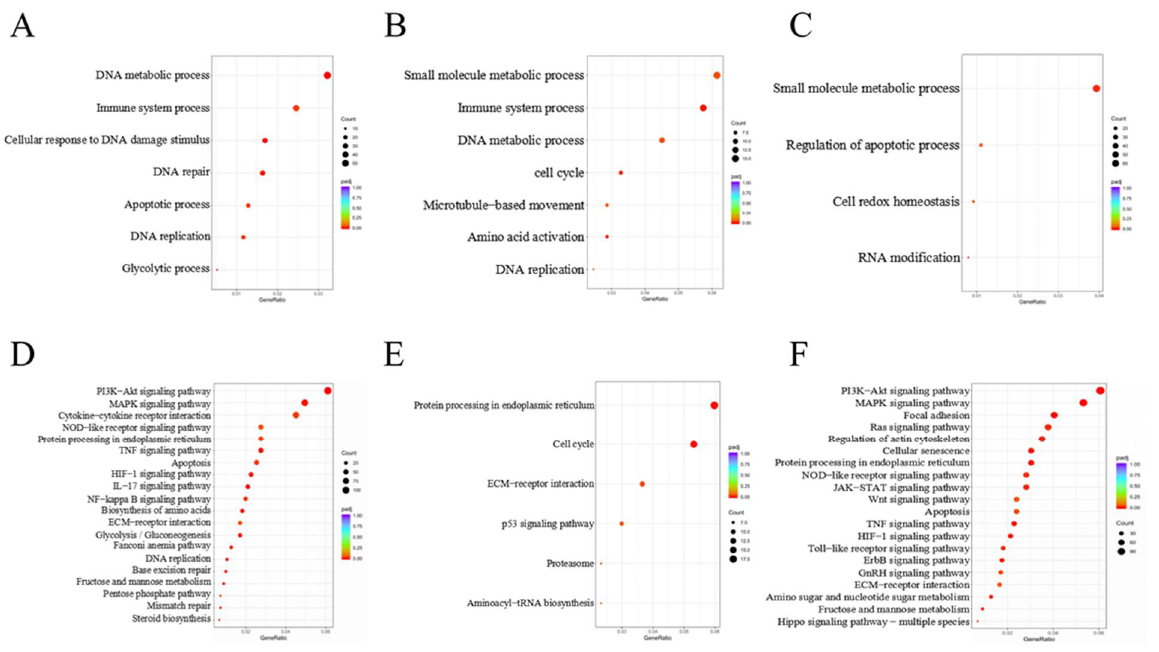
Figure 4. GO and KEGG biological processes involving DEGs in Equus asinus SCs exposed to DON and ZEA. ( A ) GO enrichment of 5763 DEGs in the 10 µ M and 30 µ M DON-exposed Equus asinus SCs, including biological process, cellular component, and molecular function. ( B ) GO enrichment of 685 DEGs in the 10 µ M and 30 µ M ZEA-treated Equus asinus SCs. ( C ) GO enrichment of 5262 DEGs in the SCs of 30 µ M ZEA treatment group. ( D ) KEGG enrichment of the 5763 DEGs in the 10 µ M and 30 µ M DON-exposed Equus asinus SCs. ( E ) KEGG enrichment of the 685 DEGs in the 10 µ M and 30 µ M ZEA treated group. ( F ) KEGG enrichment of the 5262 DEGs of 30 µ M ZEA treatment group. The lengths of the bars indicate the number of DEGs that are enriched in each pathway. The blue to red gradient represents the p.adjust trend from high to low.